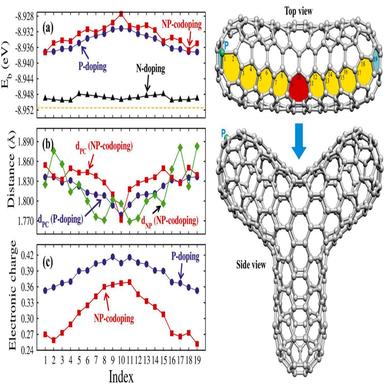
DFT-calculations in a Y-junction formed by armchair (5,5) carbon nanotubes. (a) Binding energy (Eb) for P-doped, N-doped, and NP-codoping systems. The dashed horizontal line indicates the Eb for pristine or undoped Y-Junction. (b) Interatomic distance between Phosphorus-carbon (dPC) and phosphorus-nitrogen (dNP), and (c) electronic charge excess from Mulliken population analysis in phosphorus atom. The index indicates the site dopant position illustrated in the stick-ball model (top view). Pentagon, hexagon